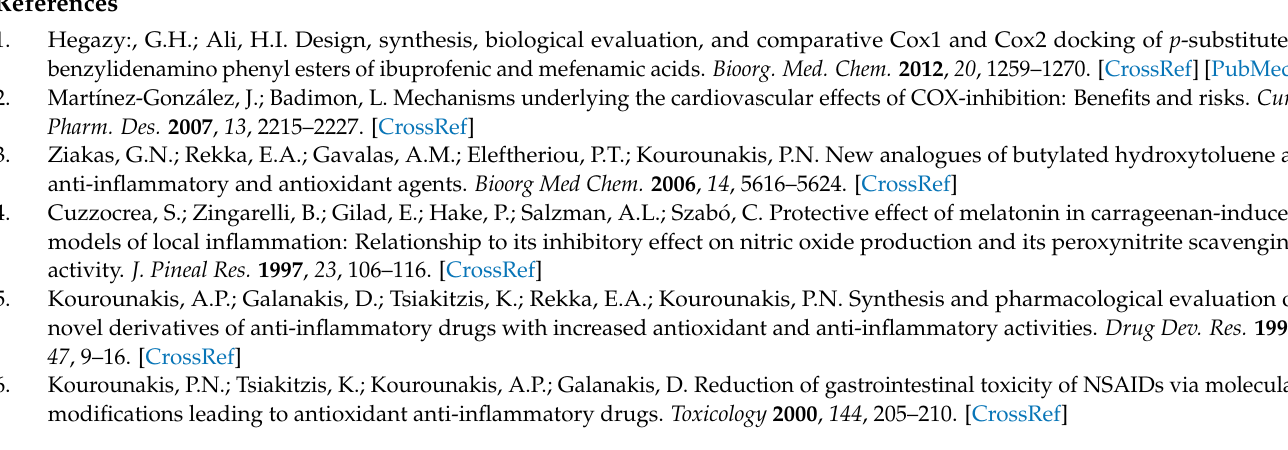
Figure S3: Superimposition of crystallographic position of 13S-Hpode (PDB id 1IK3) and EPG (PDB id